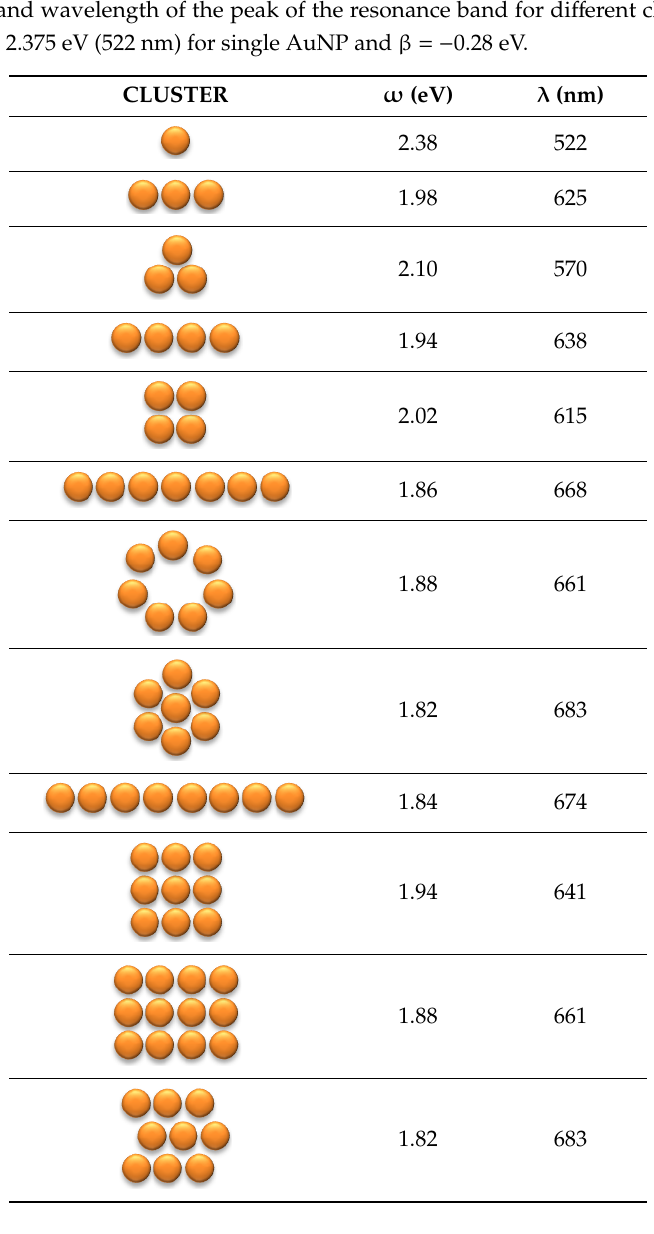
Figure 7. Comparison of results of the present work and Reference [37] in the case of triangle, square, and heptamer clusters. Input data have been estimated from Reference [37] and are  0 = 2.15 eV and  = −0.28 eV. 5. Effect of the Surface The effect of the metallic surface on the chain plasmon resonance is of great interest and has been investigated by several authors (see [20,38–41]). Two approaches may be feasible in the context of the VM. Applying the first approach, we can directly couple the surface plasmon energy independently with all the single NPs constituting the chain. From the mathematical point of view,